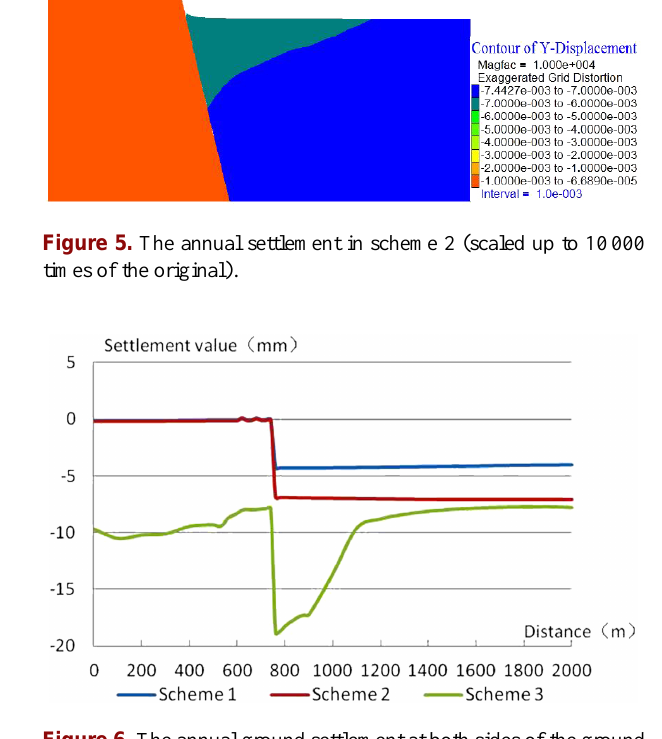
Figure 6. The annual ground settlement at both sides of the ground fissure under different